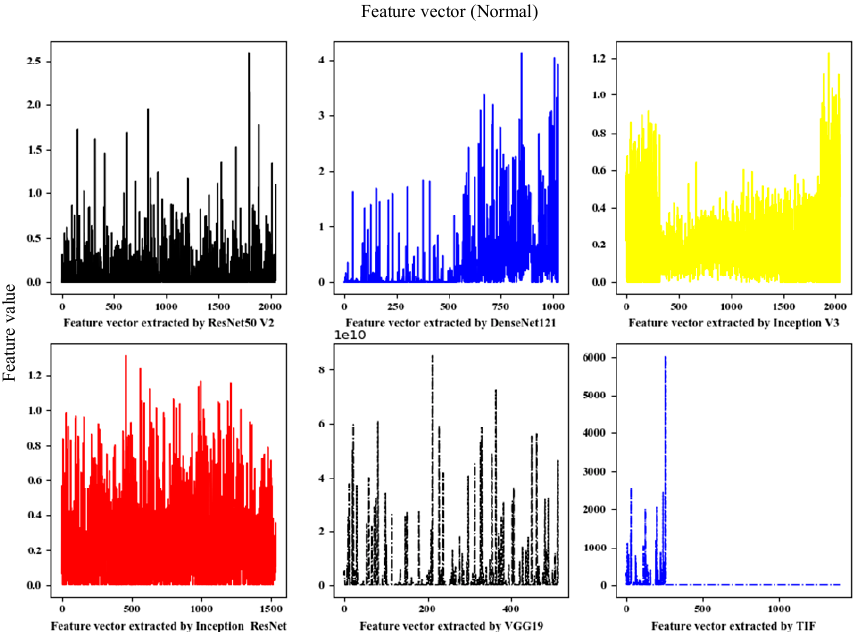
Figure 3. Feature vector extracted by deep model and Traditional image features (TIF).